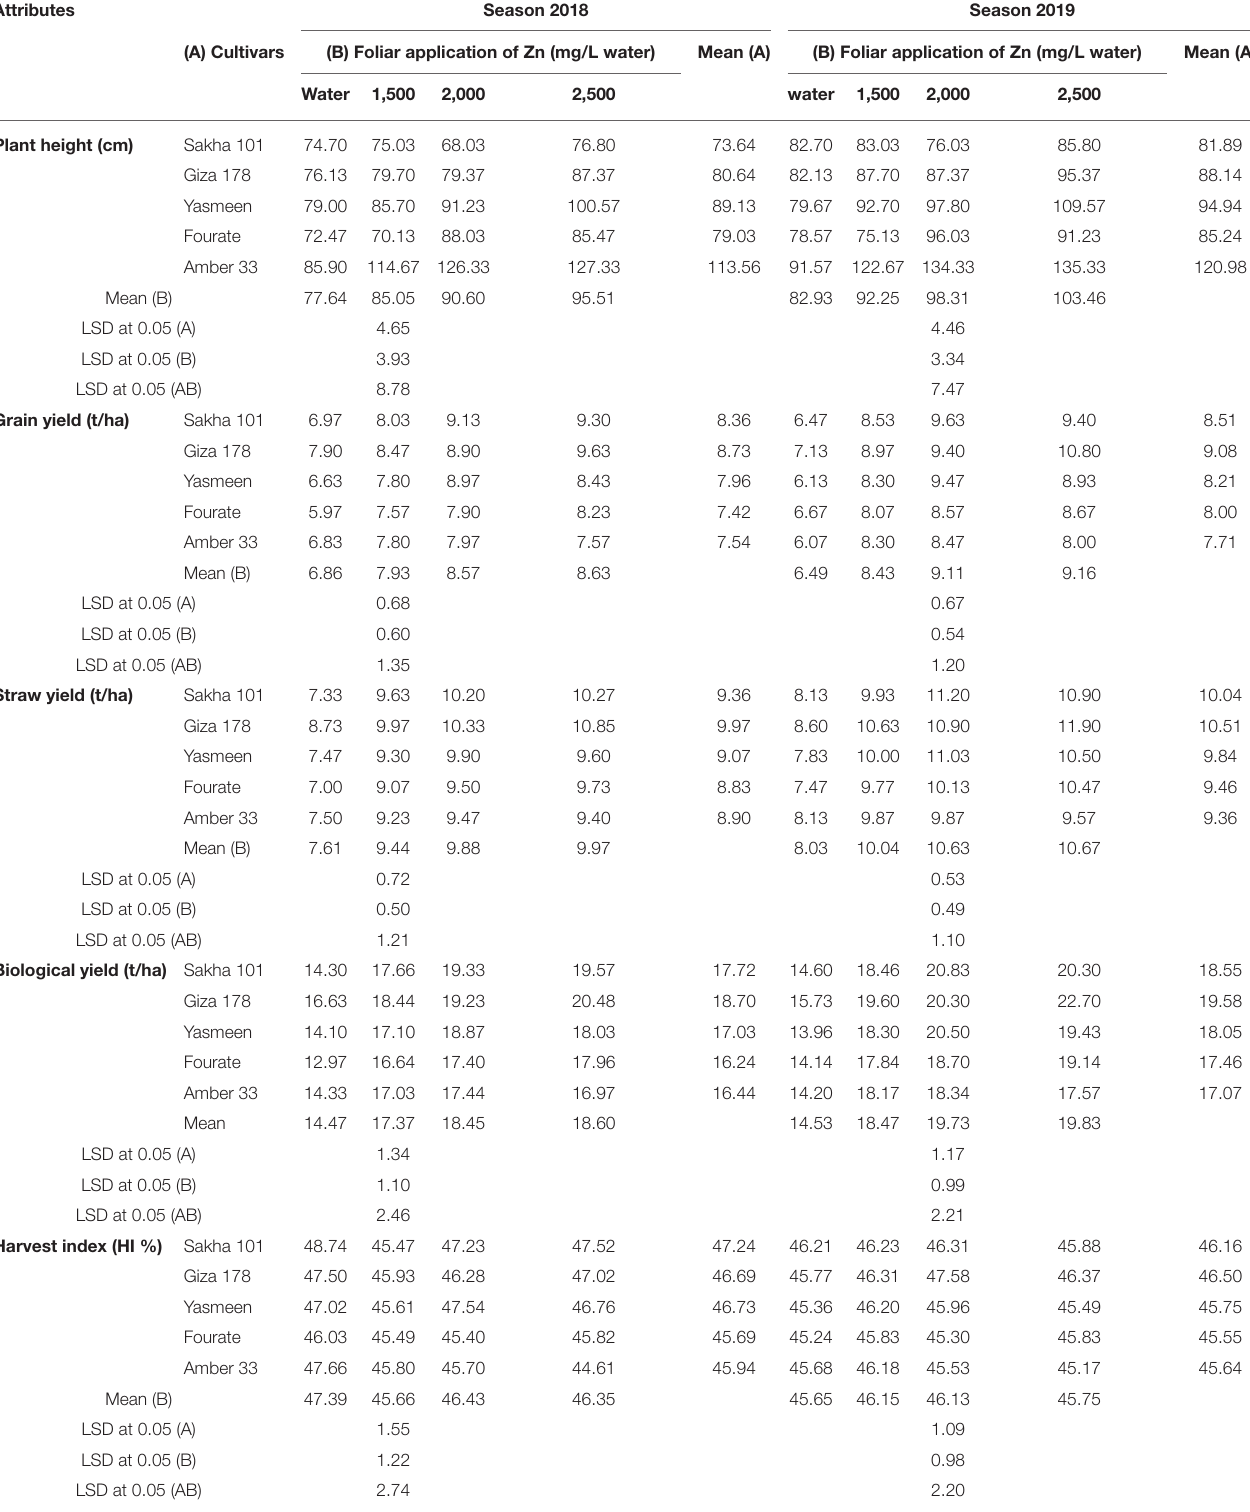
TABLE 2 | Plant attributes of some rice cultivars affected by the concentration of Zn during the 2018 and 2019 seasons.